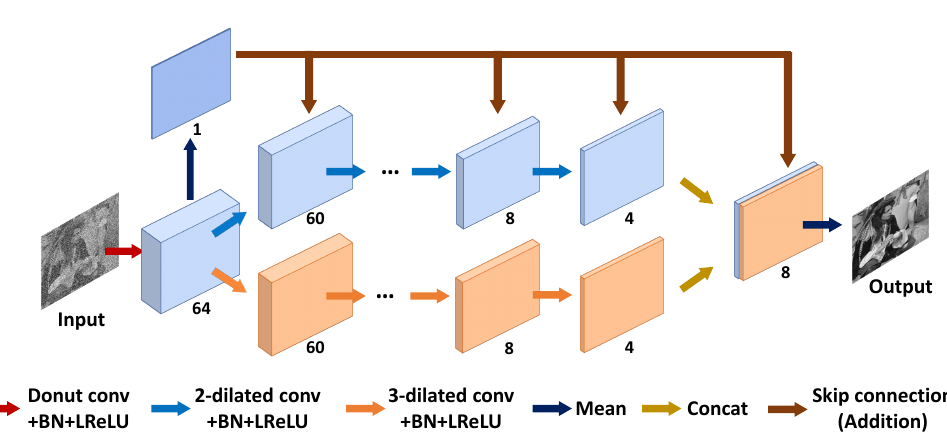
Figure 2. Overview of the network structure of